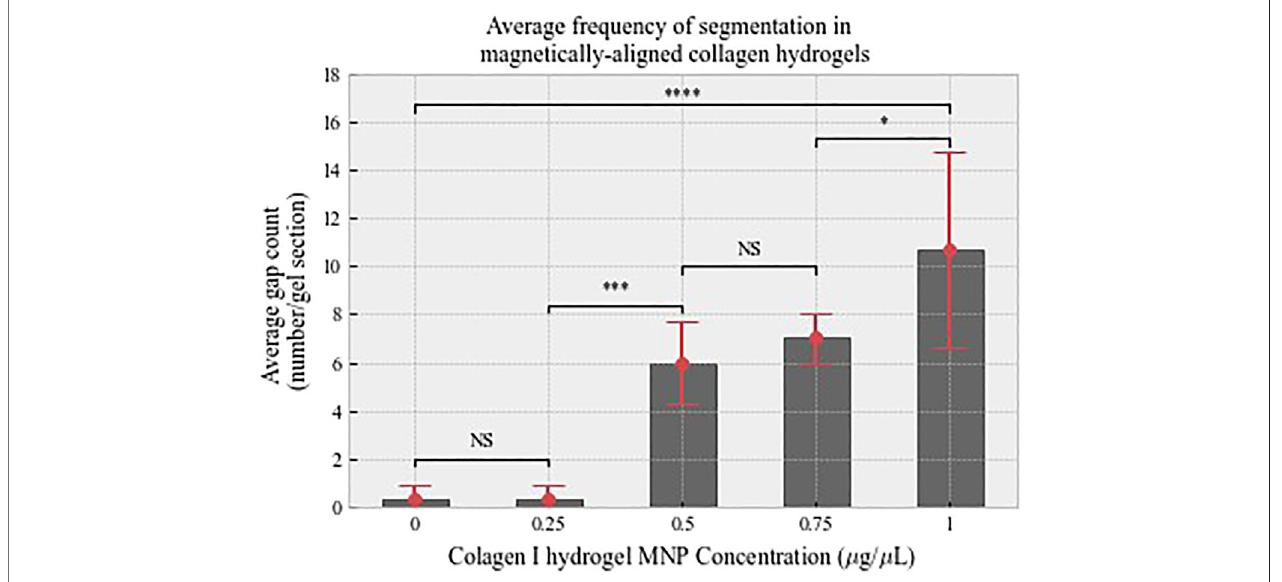
FIGURE6 | Average count ofinterspersinggaps that de fi ne fi ber-like structuresanalyzed from confocal data.There is apositive relationship betweenMNP dosing and segmentation. n = 3, error bars show standard deviation. Shown levels of signi fi cance p < 0.001 is denoted by ***, and p < 0.0001.